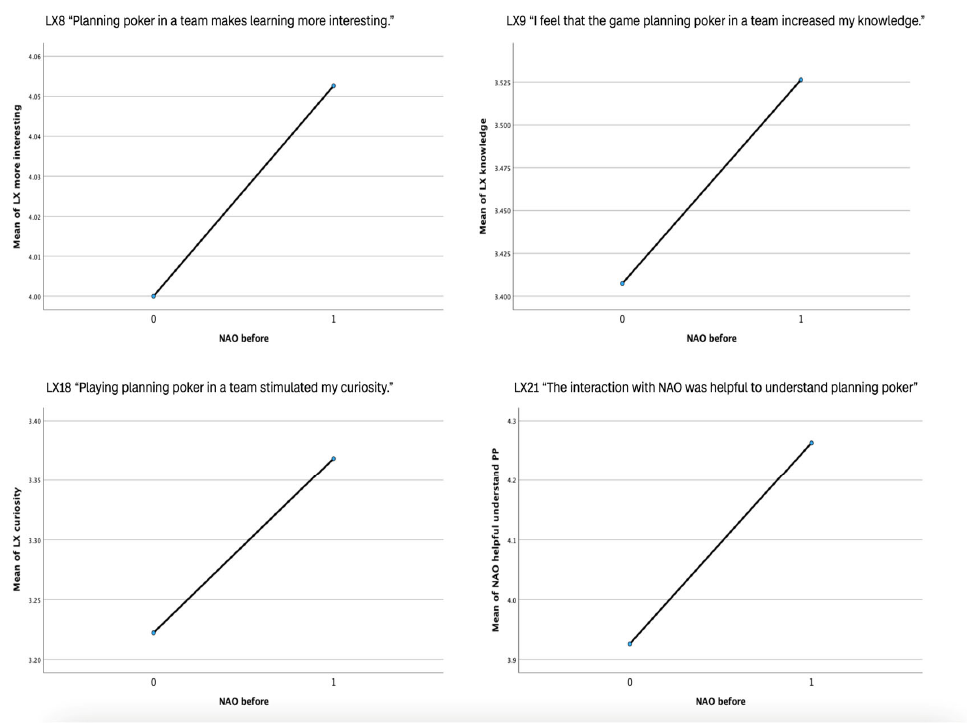
Figure 4. Learning experience of students with (1) and without (0) previous experience with NAO.